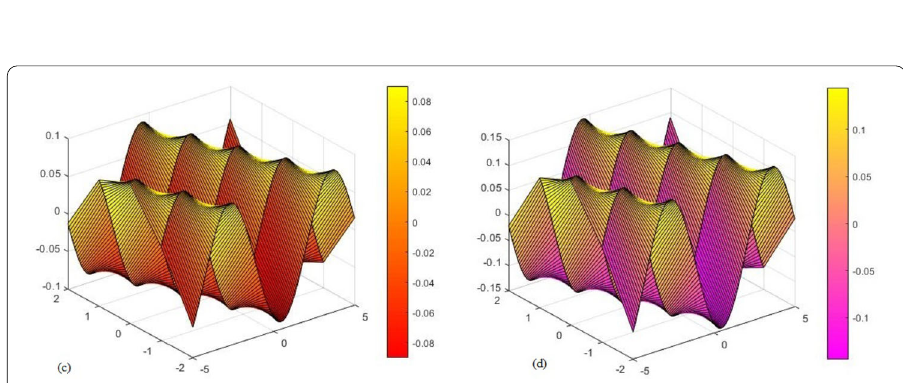
Figure 5 The graph of different approximate solution of (cid:13) ( χ , ϕ , η ) at ϒ = ( c ) 0.8 and ( d ) 0.6 of Example 1